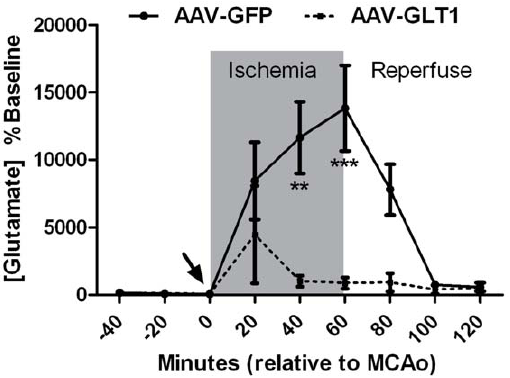
Figure 5. Pre-treatment with AAV-GLT1 reduces glutamate overflow in stroke rats. Microdialysis was performed in the lesioned cortex. In animals receiving AAV-GFP, MCAo caused an increase in extracellular glutamate. In animals receiving AAV-GLT1, MCAo -induced glutamate overflow was significantly reduced (p , 0.01, Two-way, AAV- GLT1 vs AAV-GFP post-MCAO;*p , 0.05, **p , 0.01, ***p , 0.001; Bonfer- roni test.